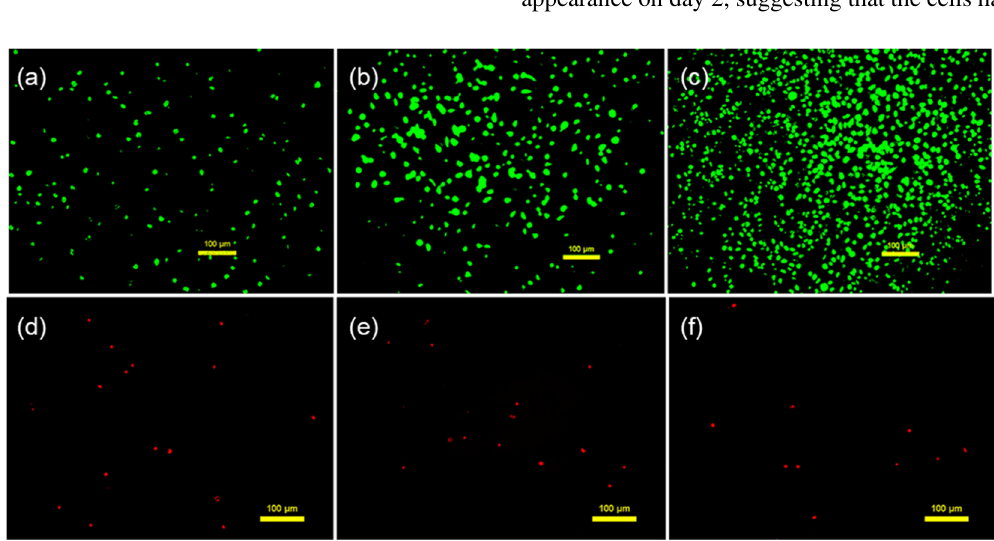
Fig. 8 Live/Dead staining of HUVECs cultured on the bioarti fi cial blood vessel: a Live cells on the bioarti fi cial blood vessel at day 2. b Live cells on the bioarti fi cial blood vessel at day 4. c Live cells on the bioarti fi cial blood vessel at day 7. d Dead cells on the the